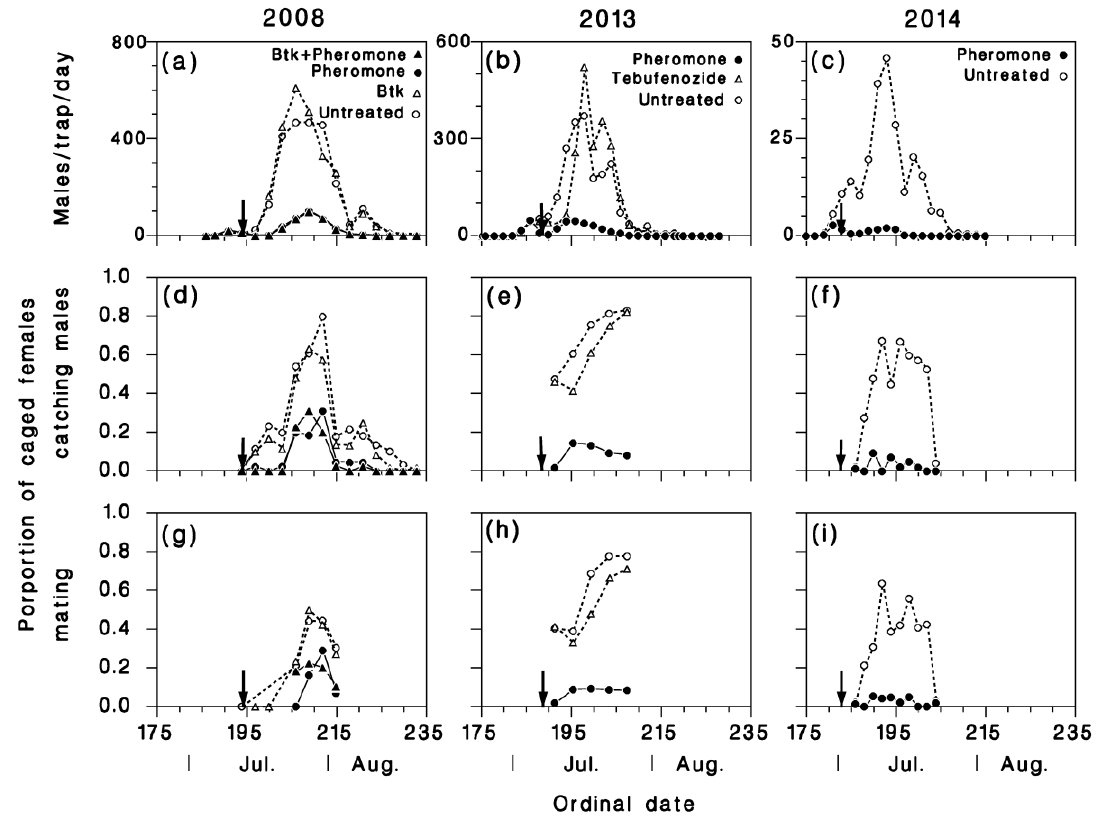
Figure 3. First row ( a , b , c ): Daily capture rates of male spruce budworm moths in pheromone traps. Second row ( d , e , f ): Success of caged virgin females at capturing males. Third row ( g , h , i ): Success of caged virgin females at getting mated. Left column: 2008. Center column: 2013. Right column: 2014.